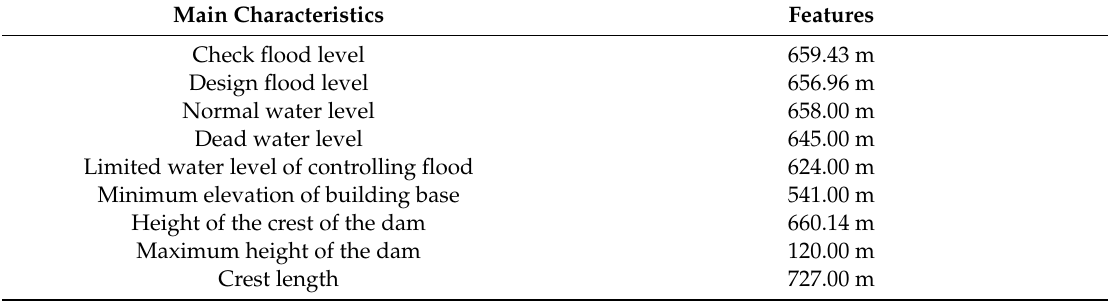
Table 1. Main technical index of the Wudu reservoir.